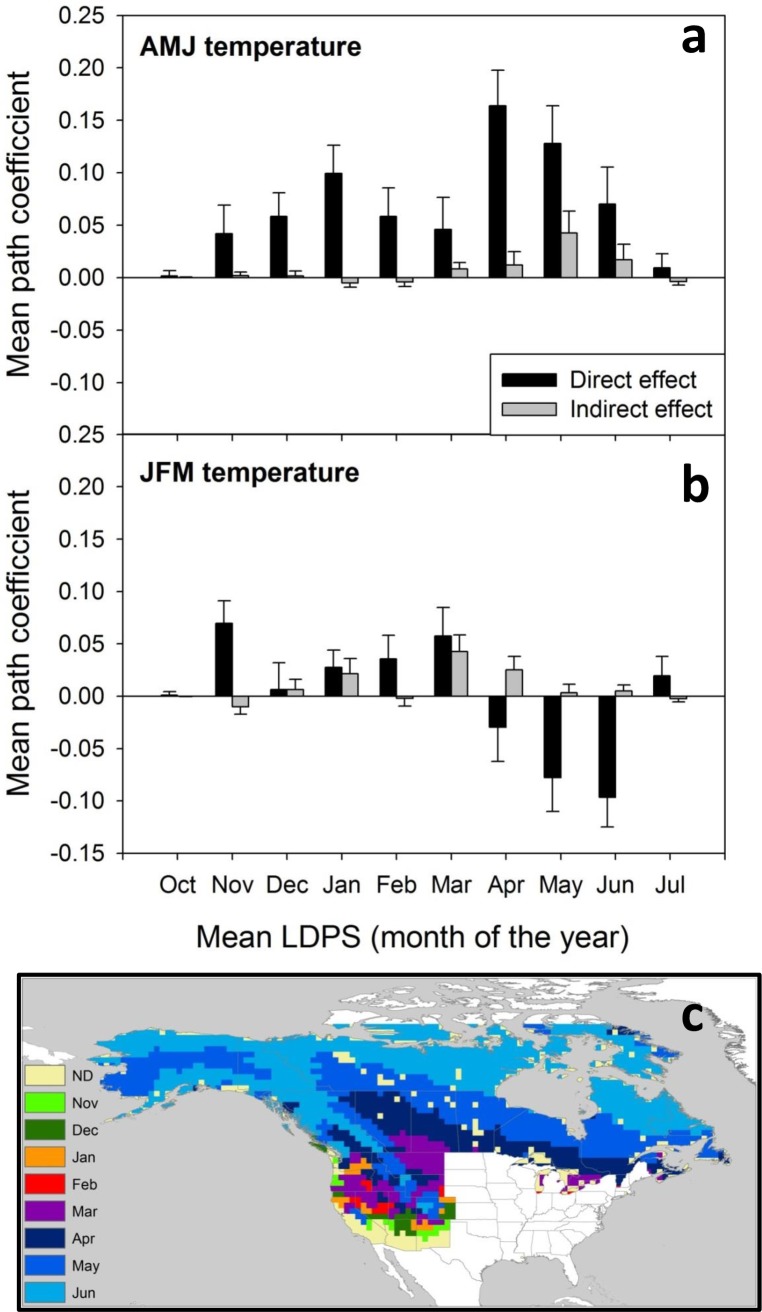
Direct and indirect effects of climate and snow cover on AAB by LDPS regions.Spring (a) and winter (b) mean (± SE) path coefficients averaged over areas of boreal and western North America with areas of similar snow cover duration (monthly classes of long-term (1972–2006) mean LDPS. Black bars indicate direct effects of temperature on log-AAB; grey bars indirect effects on log-AAB mediated by variation in LDPS. (c) Geographic distribution of monthly mean LDPS.